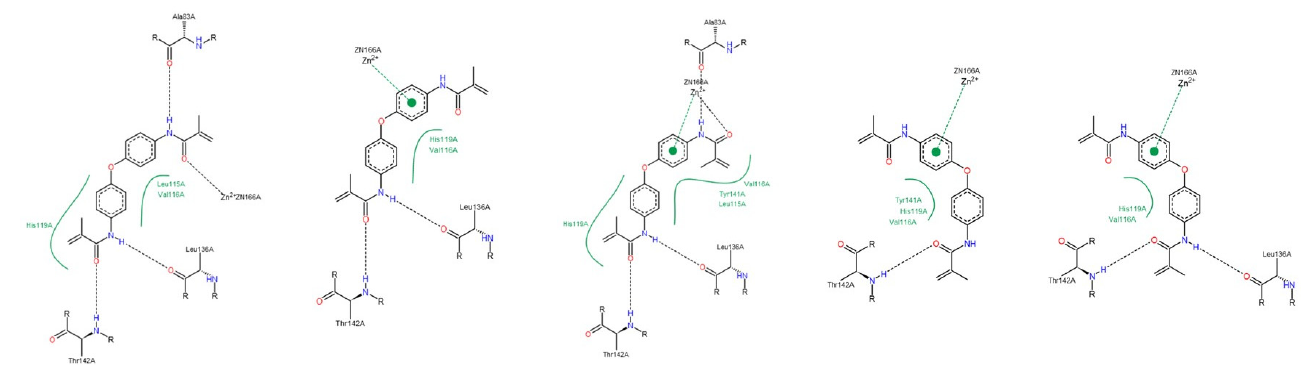
Figure A19. Interactions between compound C and MMP-9, by PoseView calculations.